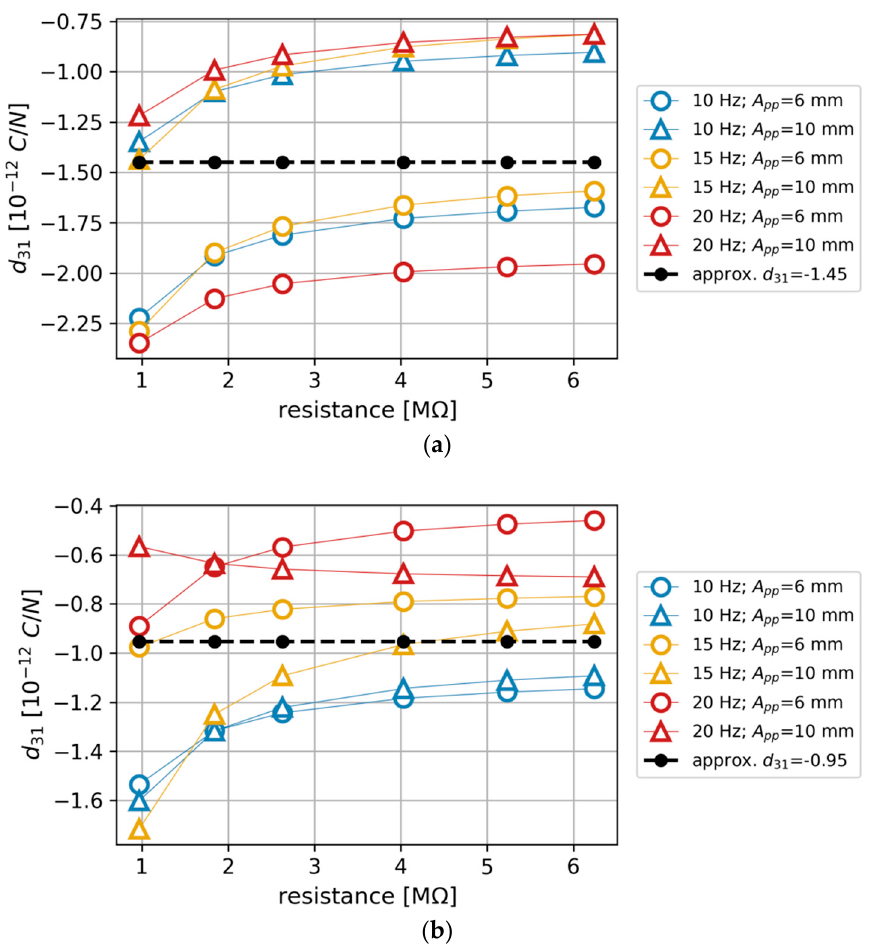
Figure 11. Values of the d 31 piezoelectric coe ffi cient estimated from the FEM simulations (A pp is peak-to-peak excitation amplitude): ( a ) for the composite beam containing an initial 50% PZT; ( b ) for the composite beam containing an initial 40% PZT.